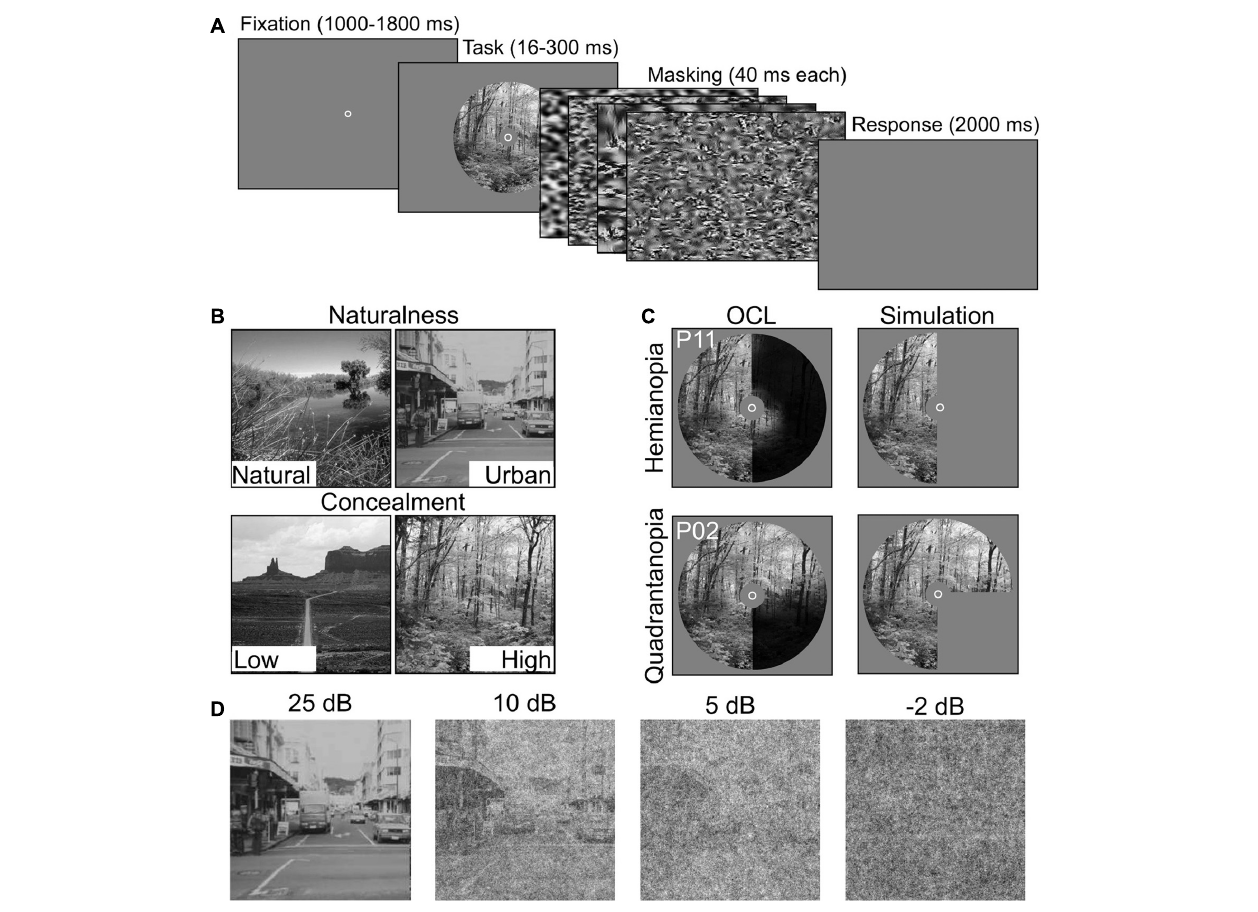
FIGURE 2 | Experimental setup and stimulus conditions. (A) Participants performed two scene discrimination tasks. Each started with a random fixation interval (between 1,000 and 1,800 ms), followed by scene images. Scene presentation time was individually determined. The scene images were backward-masked with four noise images presented for ms each. After the masking interval, participants were asked to categorize the scene as accurately and quickly as possible. (B) Example scenes for the two scene discrimination tasks (Naturalness and Concealment) and their two levels. (C) Field defects of two OCL participants (P2 and P11) compared with simulated VFD occlusion. (D) Examples of the systematic degradation using four levels of SNR, i.e., 25, 10, 5, and − 2